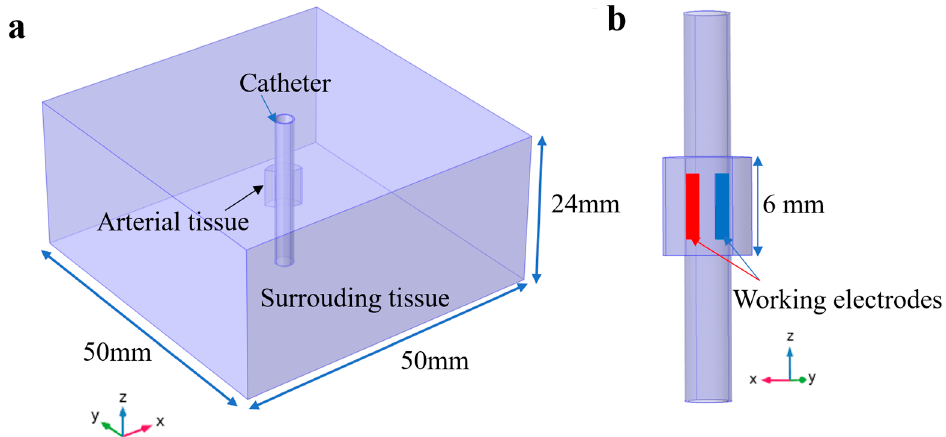
Figure 4. ( a ) The geometry setup of the model. The large block is the surrounding tissue. The small portion is the arterial tissue. The cylinder is the catheter. ( b ) An enlarged illustration of the catheter and the arterial tissue near the paired electrodes.